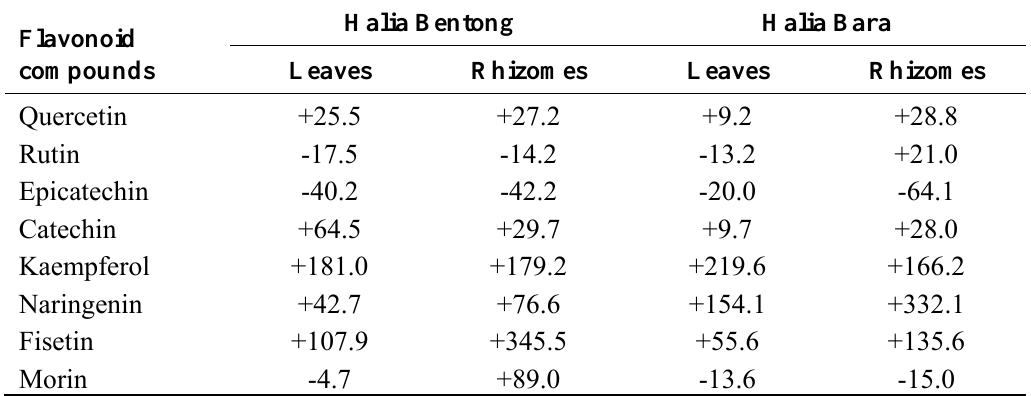
Table 2. Percent of increase or decrease of flavonoid compounds in two varieties